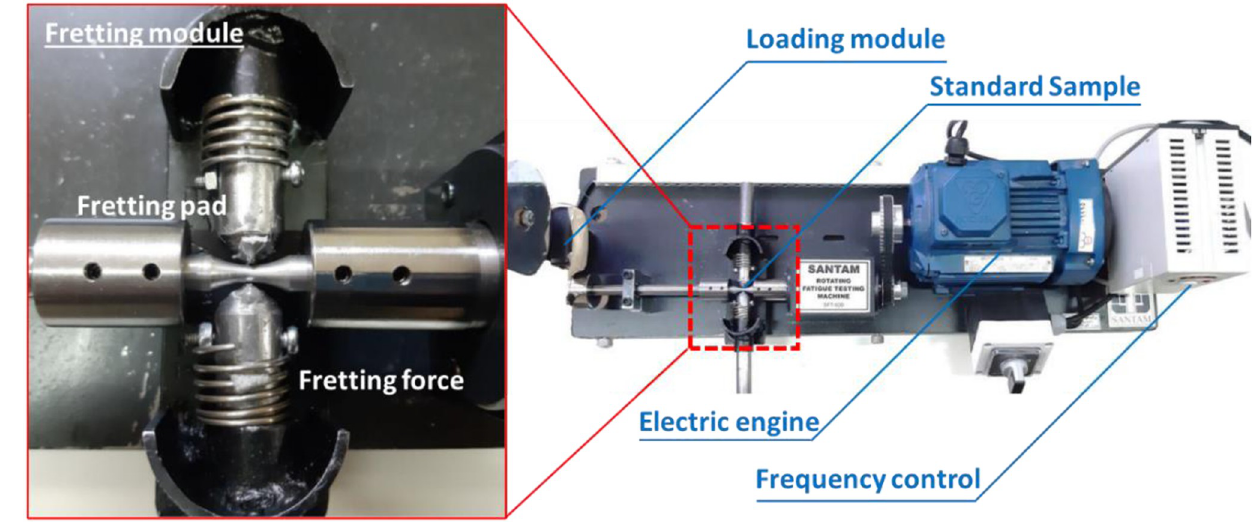
Fig 2. The rotary bending fatigue testing machine with the fretting